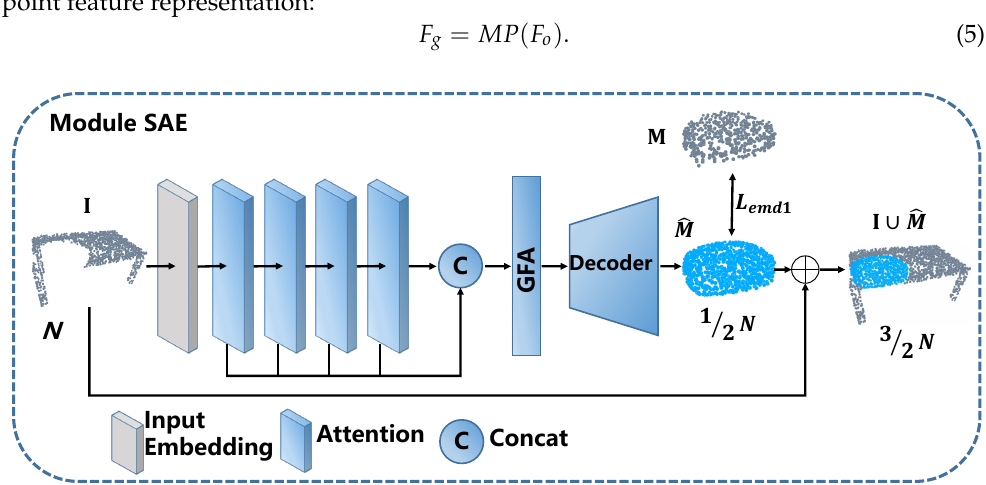
Figure 3. The 3DPCTN-SAE encoder mainly comprises an input-embedding module and four stacked attention modules. We connect the feature dimensions of the attention output of each attention layer, and then perform a linear transformation. Finally, a global feature of the missing part of the point cloud is obtained, which is fed into the missing-part network decoder to obtain a completed shape point cloud ˆ M